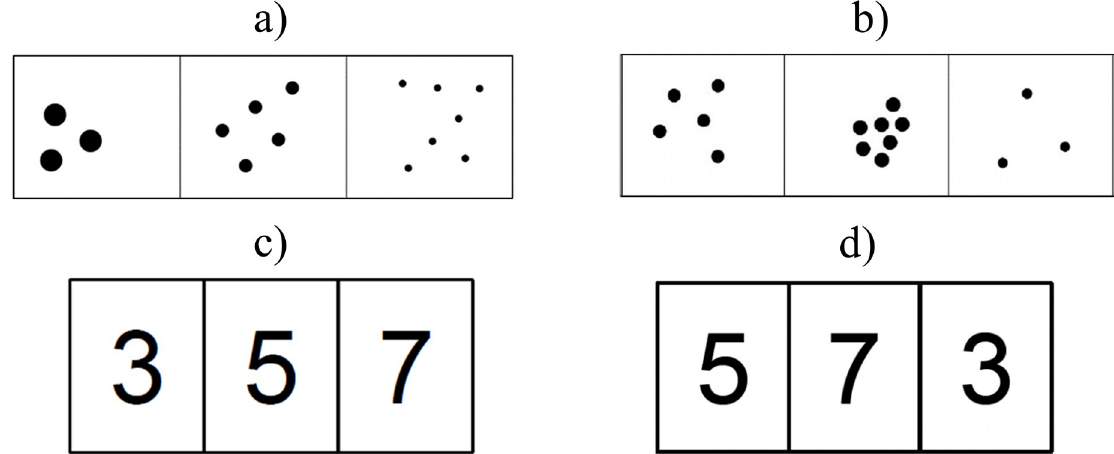
Fig 1. Example items of the non-symbolic and symbolic ordering tasks: non-symbolic a) ascending and b) not-in-order items, and symbolic c) ascending and d) not-in-order items. Children were asked to indicate whether magnitudes were presented in an ascending order or